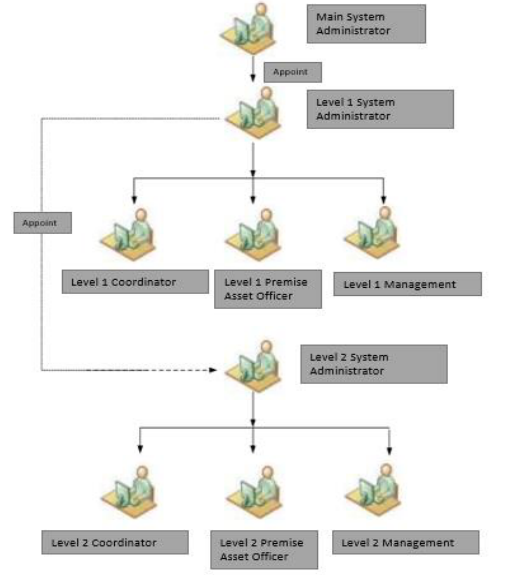
Figure 7: Example of User Hierarchy (Source: MySPATA Manual Guide)